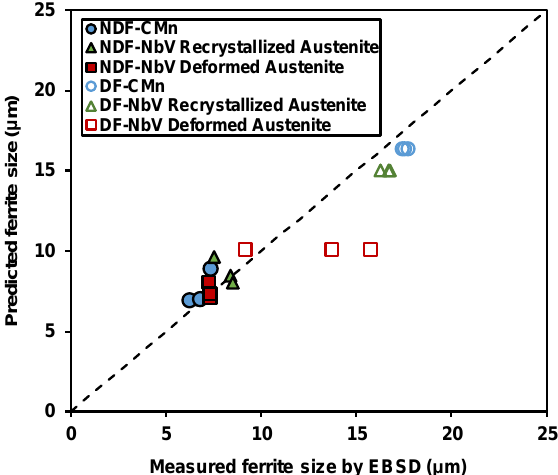
Figure 10. Predicted ferrite grain sizes considering Bengochea’s [19] equation as a function of ferrite size measured by EBSD for both chemical composition, austenite conditions, and both ferrite populations (NDF and DF).